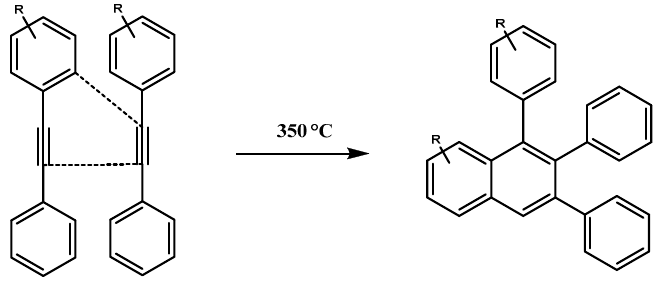
Scheme 2. The cross-linking reaction of aromatic acetylene.